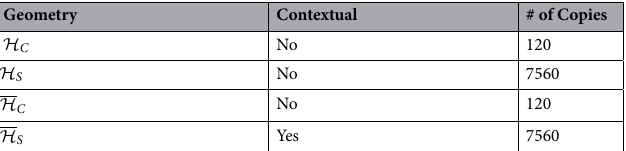
Table 1. Results on the contextuality properties of differently-embedded hexagons and their complements. The difference between the two embeddings reveals itself in terms of contextuality when one considers the complement of the